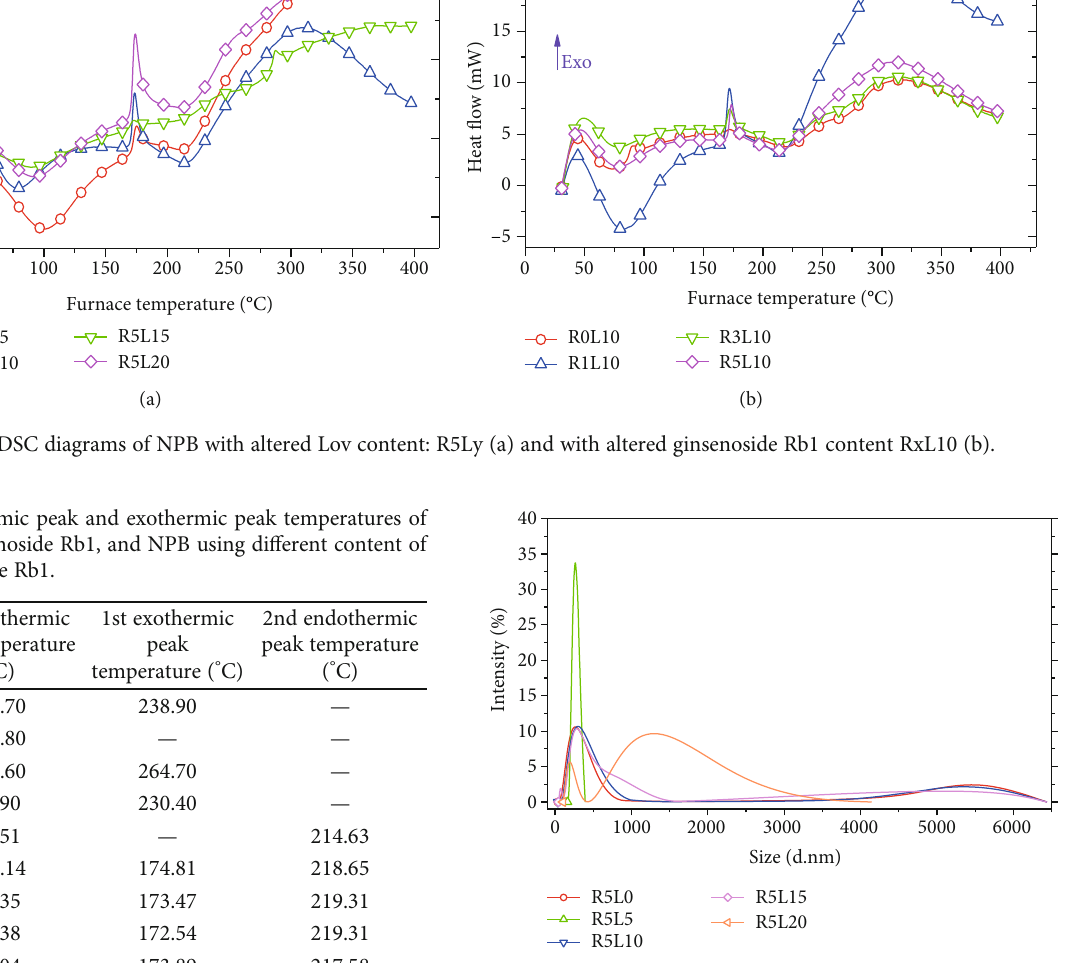
Figure 9: Particle size distribution diagram of NPB using 5wt.% ginsenoside Rb1 and di ff erent Lov content.